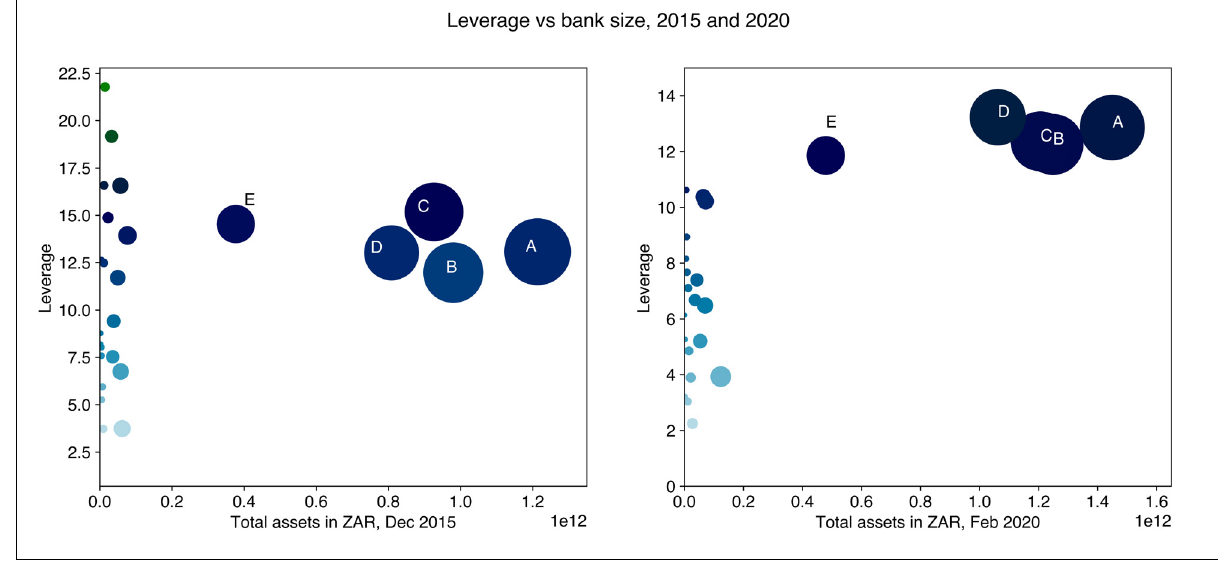
Source: South African Reserve Bank BA900 forms balance sheet data Figure 2: Leverage and total asset value of the largest 10 banks in December 2015 and February 2020. Bubble size represents market share in terms of assets. Banks are becoming more similar in terms of leverage and asset